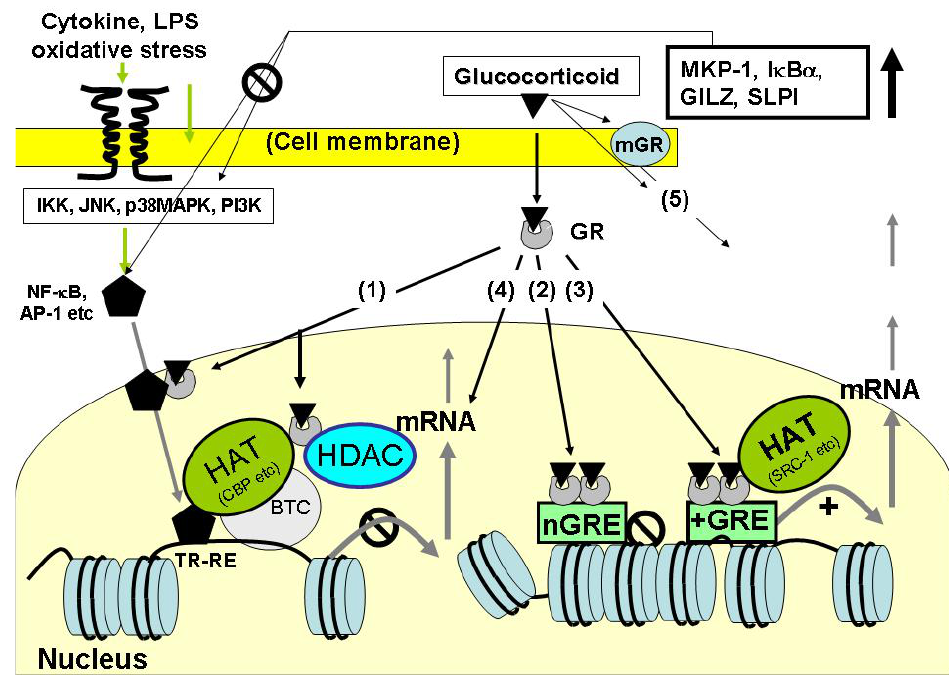
FIGURE 3. How glucocorticoids turn off gene transcription. Cytokine, oxidative stress, growth factors, and lipopolysaccharides (LPS) stimulate activation of transcriptional factors, such as NF- κ B. Activated NF- κ B translocates to nuclei and recruits HAT, and then acetylates histones. Consequently, genes are switched on as shown in the left side. GR exists in the cytoplasm (center of figure). After ligand binding, GR translocates into nuclei. (1) GR monomers associate with transcription factors-HAT complex, and finally recruit HDAC, which subsequently deacetylases histone and switches off the gene. (2) The GR dimer can bind negative-GRE to suppress transcription of some genes, such as IL- 6, directly or (3) bind the promoter region of anti-inflammatory factors (+GRE) and activate them. In addition, glucocorticoid-GR complex is involved in reduced mRNA stability (4) and reduced translation of proinflammatory cytokines. Furthermore, GR may act directly (nonspecifically) or via membrane bound GR (mGR)